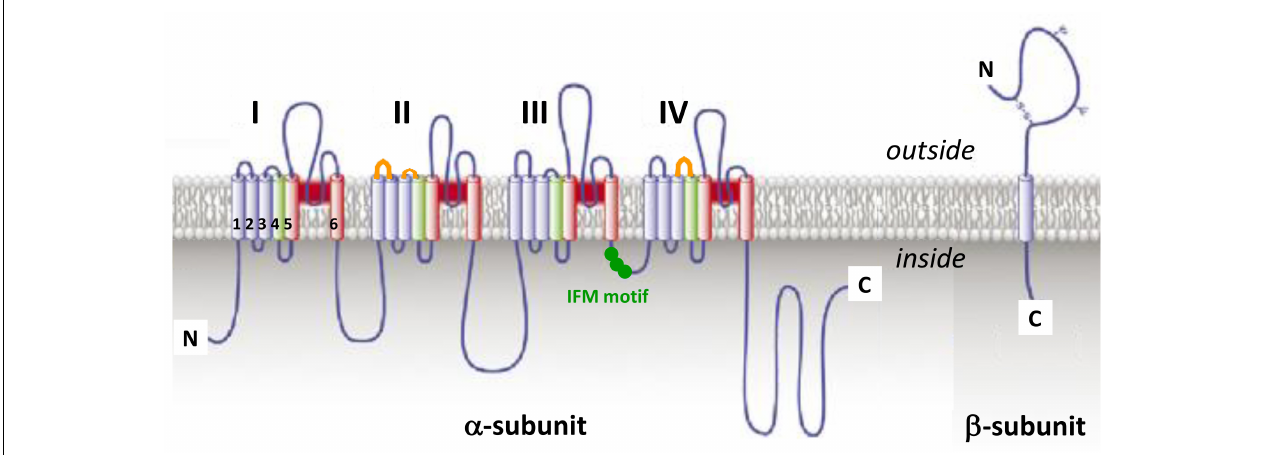
FIGURE 3 | The voltage-gated sodium channel. Schematic representations of α -subunit and auxiliary β -subunit of Na V channels, in which cylinders are transmembrane α helices. In red: S5 and S6 pore-forming segments, in green: S4 voltage-sensor segment, and in blue: S1, S2, and S3 segments. IFM, isoleucine, phenylalanine and methionine residues. The orange loops in DII and DIV domains correspond to spider toxins binding sites (adapted from Catterall et al., 2007).